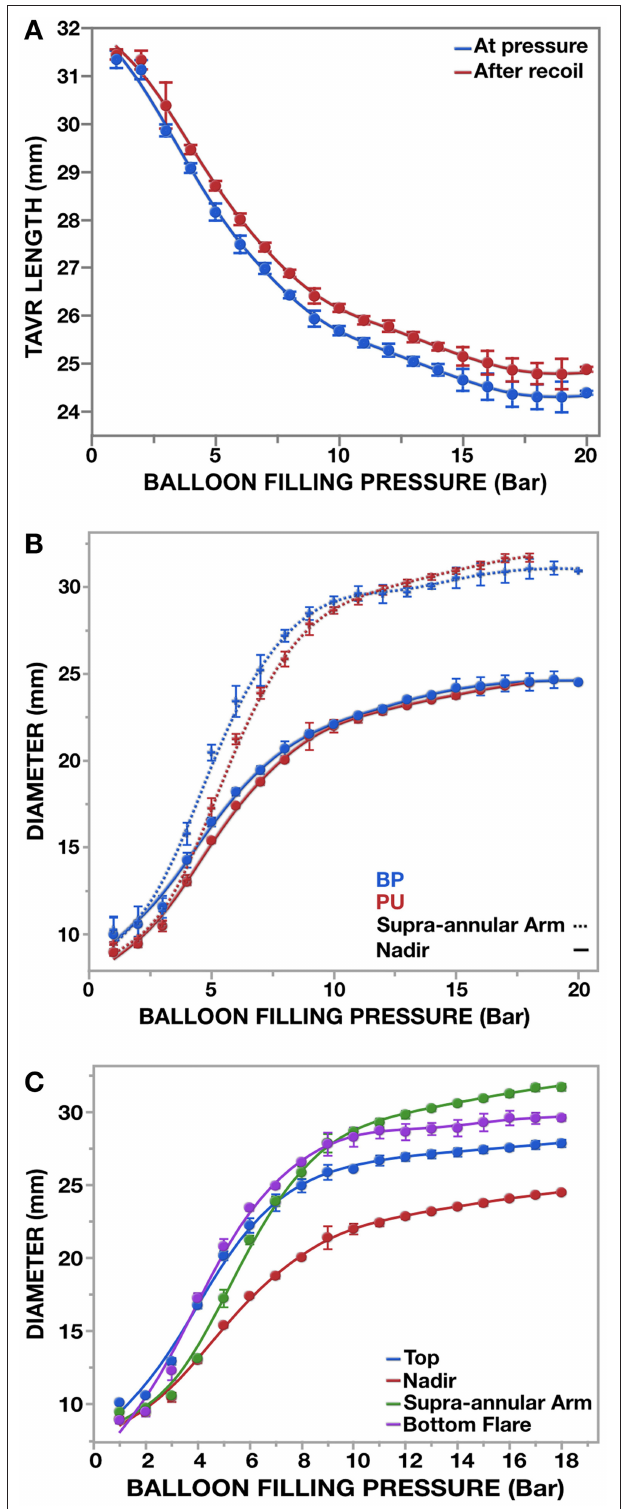
FIGURE 7 | Outer dimensions of (M)-size pericardial (BP; n = 3) and polymer (PU; n = 3) SAT valves during expansion with a 26mm non-occlusive SAT